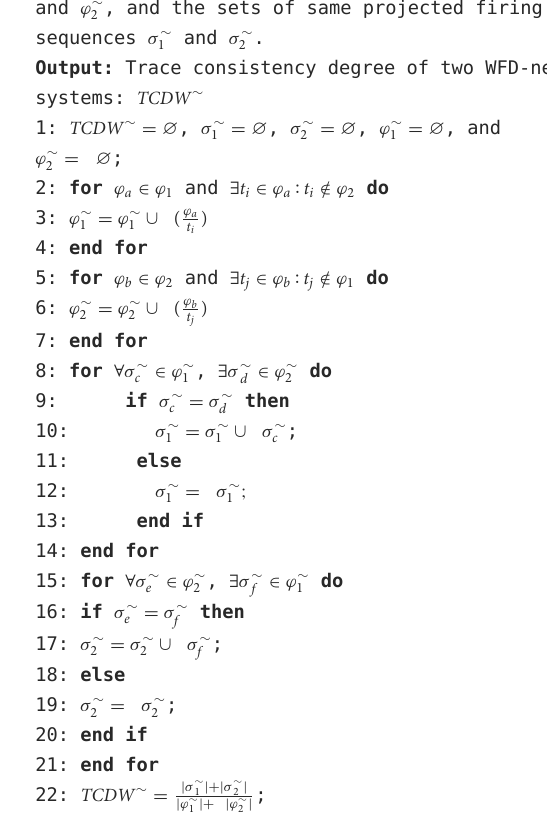
rotes are reserved among transitions with correspondences in